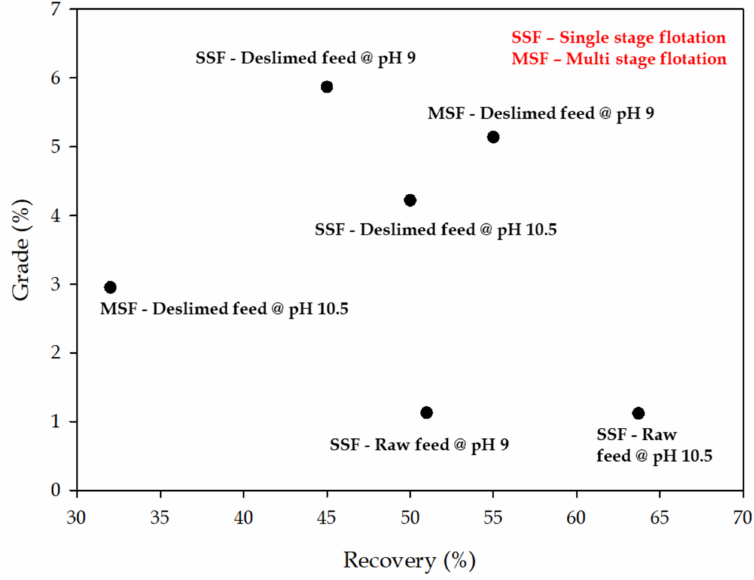
Figure 12. TREO grade–recovery curve comparing the performance of different flotation methods tested in this